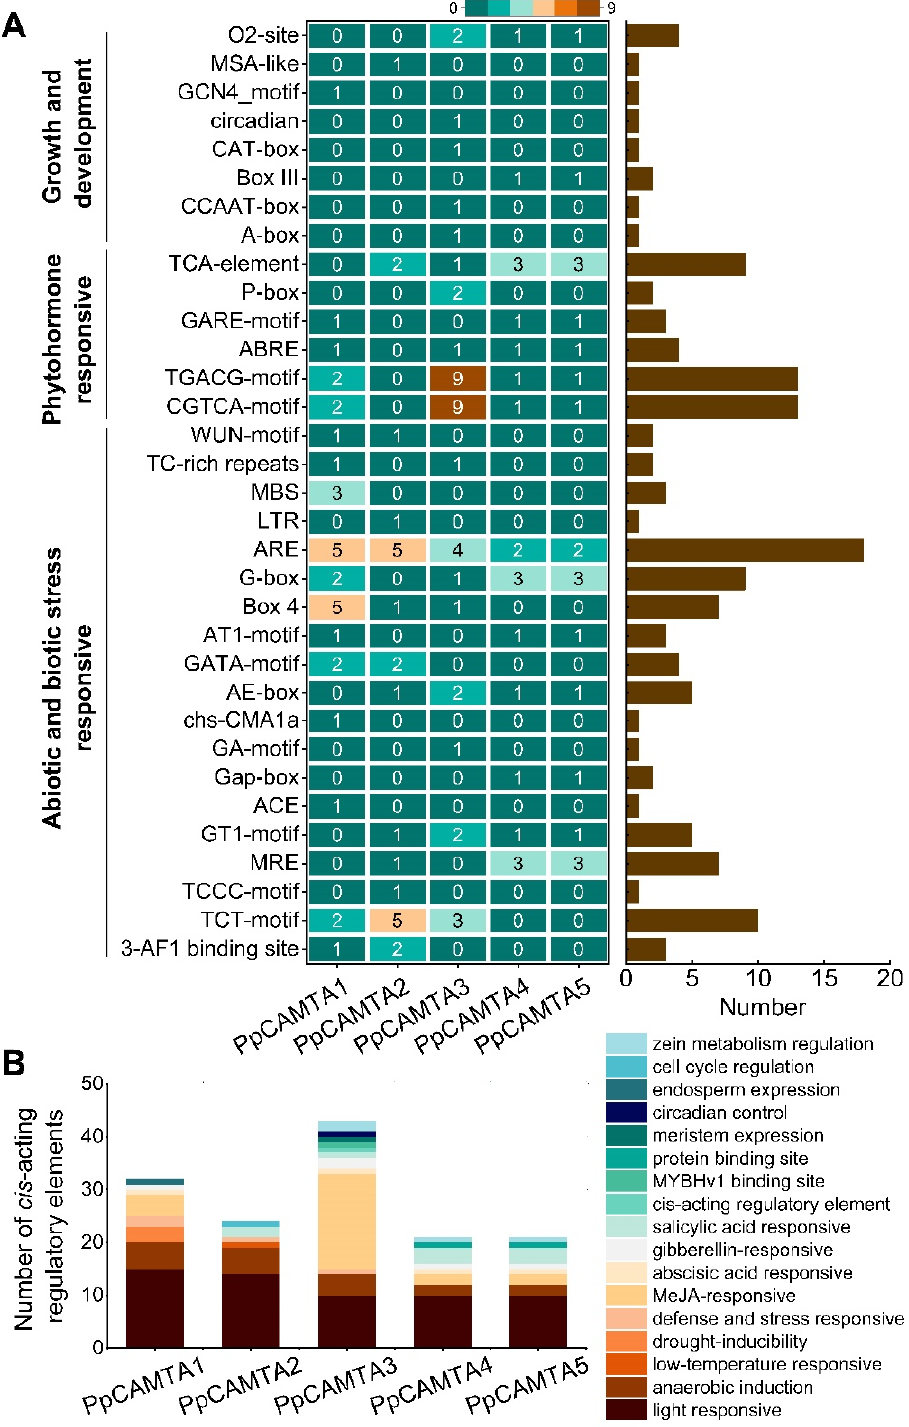
(Figure 3A). For instance, PpCAMTA1 had TC-rich repeat and WUN-motif which respond to defense and stress.